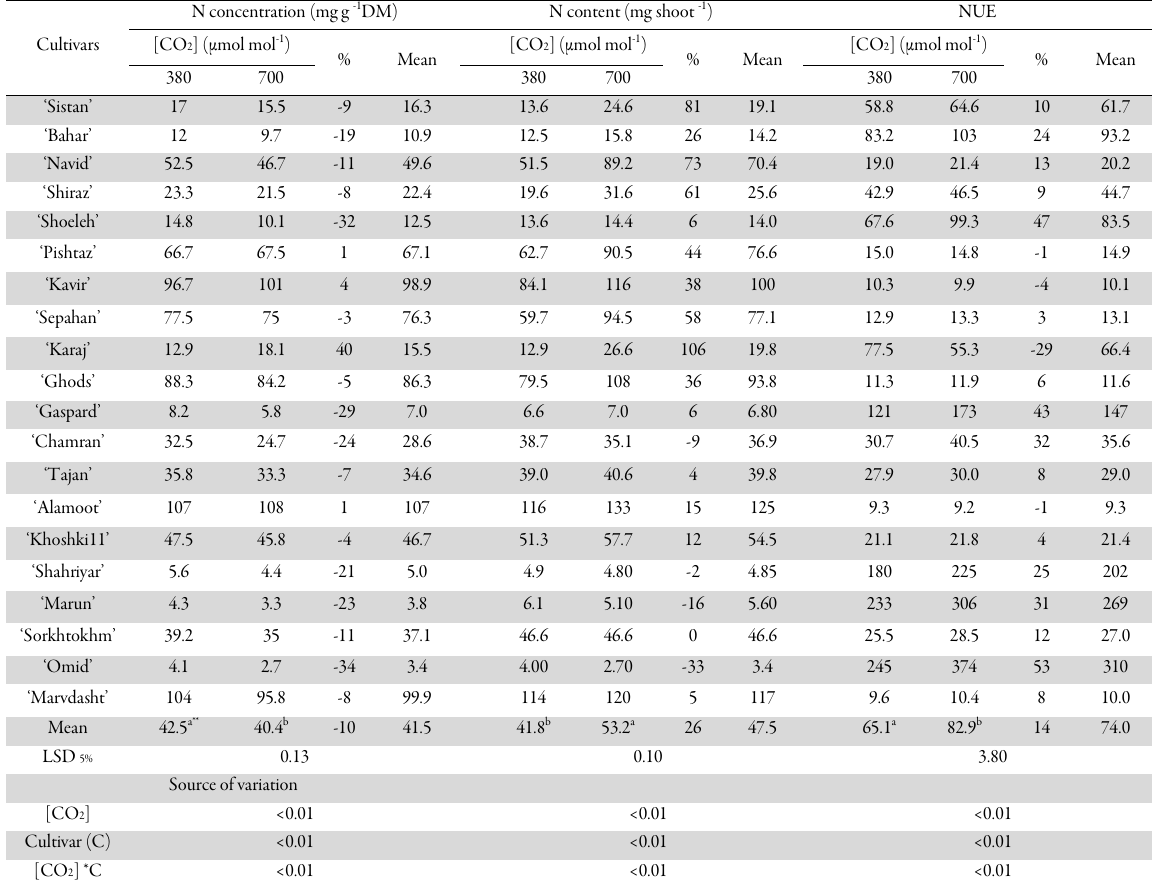
Table 2. Effects of two [CO 2 ] (380 ± 50 vs. 700 ±50 µmol mol -1 ) on nitrogen concentration (mg g -1 DM), nitrogen content (mg shoot -1 ) and NUE in the shoots of 20 Iranian bread wheat cultivars Cultivars